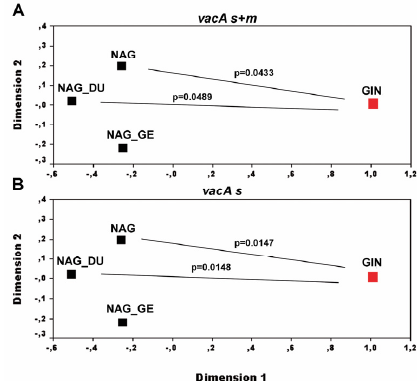
Figure 2. Multidimensional scaling plot of 45 Helicobacter pylori vacA s and m sequences obtained in this study (red: gastric intraepithelial neoplasia, GIN; green: non-neoplastic gastro-duodenal lesions, NNGDLs) and of 55 worldwide Helicobacter pylori sequences from GenBank (blue), based on the vacA gene (both s and m regions). Scaled stress value = 0.0208.